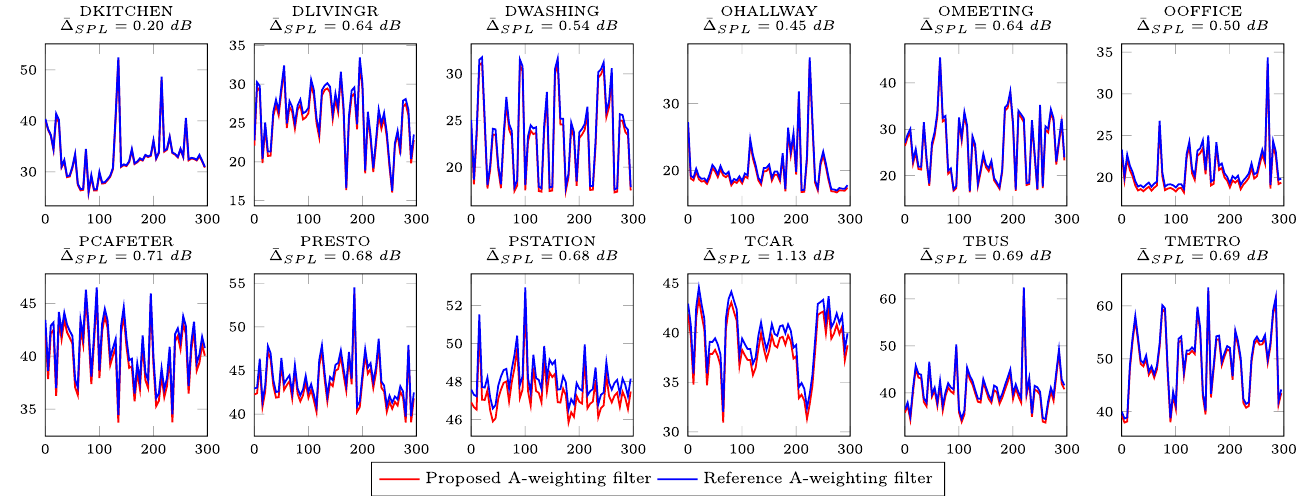
Figure 10. Sound pressure level profile for each of the recordings in the DEMAND collection. ¯ ∆ SPL denotes the mean absolute error between the SPL values obtained with the proposed and the reference A-weighting filters.